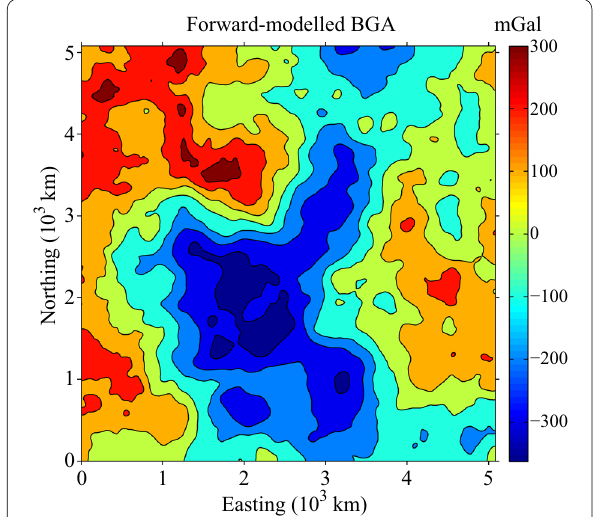
Fig. 3 Forward‑modelled Bouguer gravity anomaly